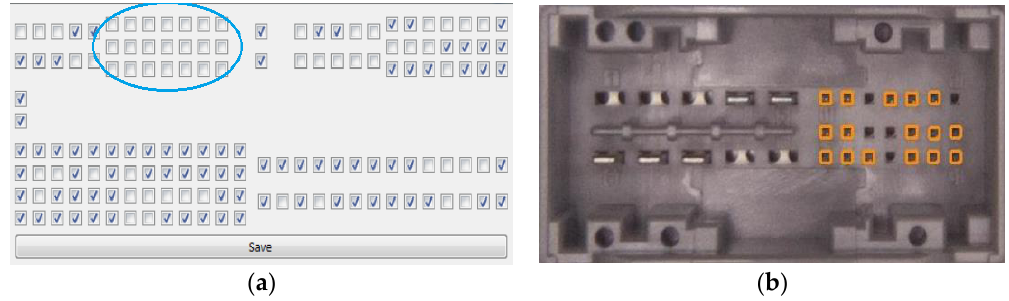
Figure 22. Results obtained with the IP-LC-FD system: ( a ) the unmarked pins in the Pattern Learner module for a connector; ( b ) the detected extra pins in the specified connector.